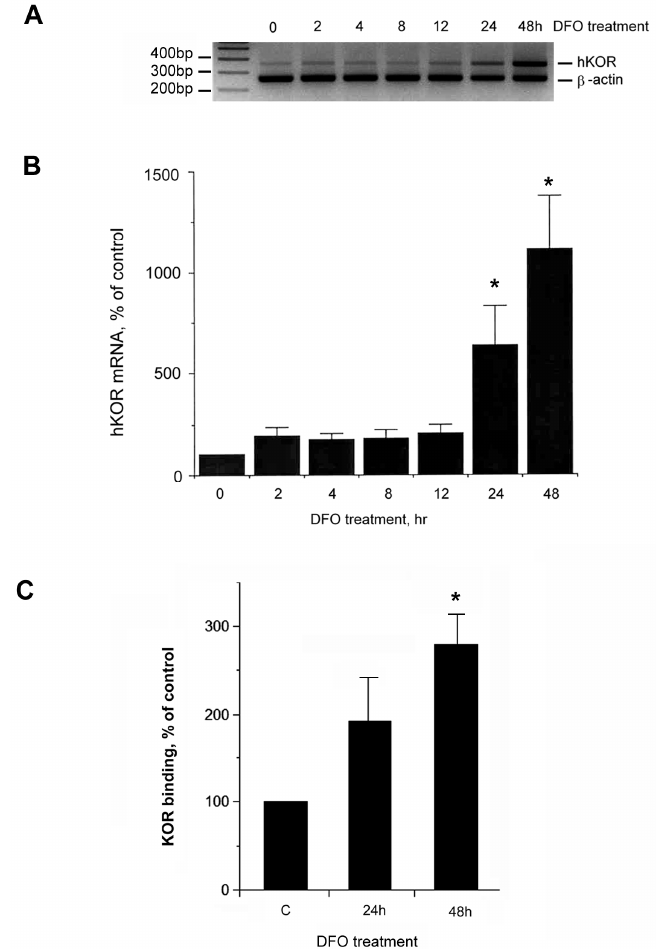
Figure 8. Effect of DFO on hKOR expression at various time points. ( A ) Cells were treated without (control; indicated as “0”) or with DFO for various different time points (2 to 48 h). RNAs from surviving/attached cells were extracted. Semi-quantitative RT-PCR was performed using hKOR-specific primers with human β -actin specific primers as an internal control for normalization; ( B ) the normalized message from the non-DFO treated control (labeled as “0”) was arbitrarily defined as 100%. Quantitative analysis of message levels are presented as mean ± S.E.M. Experiments were repeated at least ten times. “*” indicates p < 0.01. (Student t -test); ( C ) the level of hKOR proteins was determined by the receptor-ligand binding assay. Two nM of [ 3 H]-diprenorphine was used as the labeled ligand, and U50, 488H (1 µ M) was included as the competitive ligand. In order to block the bindings to delta and mu opioid receptors, 1 µ M of DAMGO and DADLE were also added to all reactions. Membranes from NMB cells treated without DFO (control; C) or with DFO for 24 or 48 h were used for the competitive binding assay. Specific binding was denoted as the difference between samples in the absence and presence of 1 µ M U50, 488H. Specific [ 3 H]-diprenorphine binding of the control (the non-DFO treated sample) was designated as 100%. The binding was normalized by the same amount of proteins. Histograms of KOR bindings are presented as mean ± S.E.M. Experiments were repeated six times. Asterisk “*” indicates p < 0.01 ( t -test).